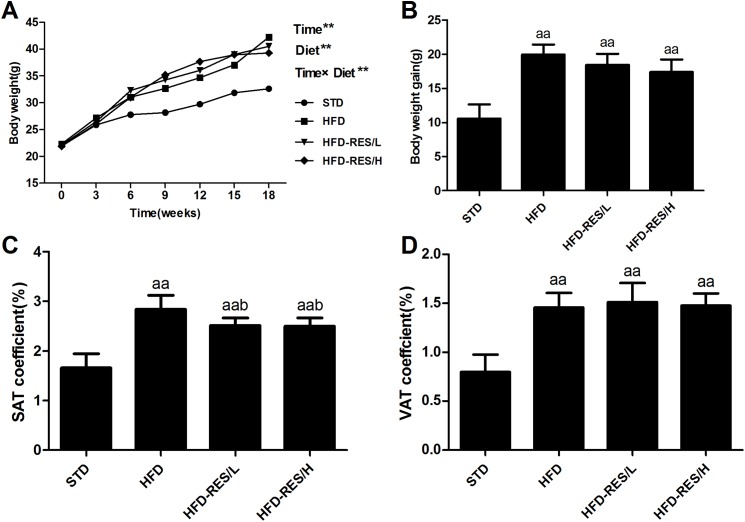
Effects of RES treatment on body weight curve, body weight gain and subcutaneous/visceral adipose coefficients of mice in response to resveratrol treatment.(A) Body weight curve; (B) Body weight gain; (C) SAT coefficient; (D) VAT coefficient. aa, P < 0.01 vs. the STD group; b, P < 0.05 vs. the HFD group. Time** indicates exposure duration. Diet** indicates the variety of diet. Time × diet** indicates the interaction effect between treatment duration and variety of diet. Data are expressed as the mean ± SD.